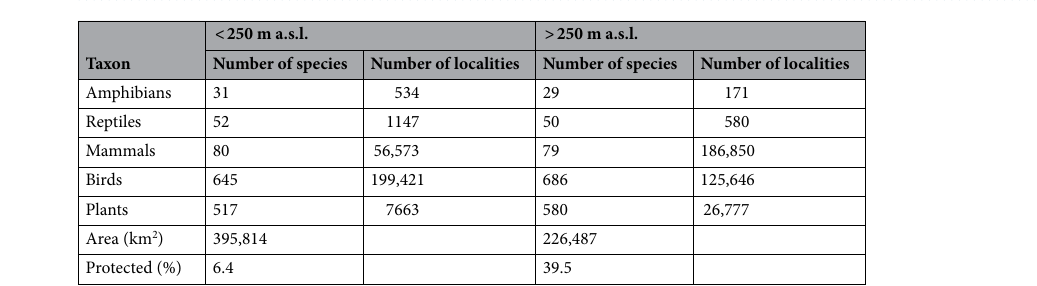
Figure 2. Maps of ( a ) the six regions of Thailand used in the text, and ( b – f ) species occurrence locations used in the analyses for each major taxon. Maps created in ArcMap 10.5 (https:// suppo rt. esri. com/ en/ produ cts/ deskt op/ arcgis- deskt op/ arcmap/ 10-5-1).